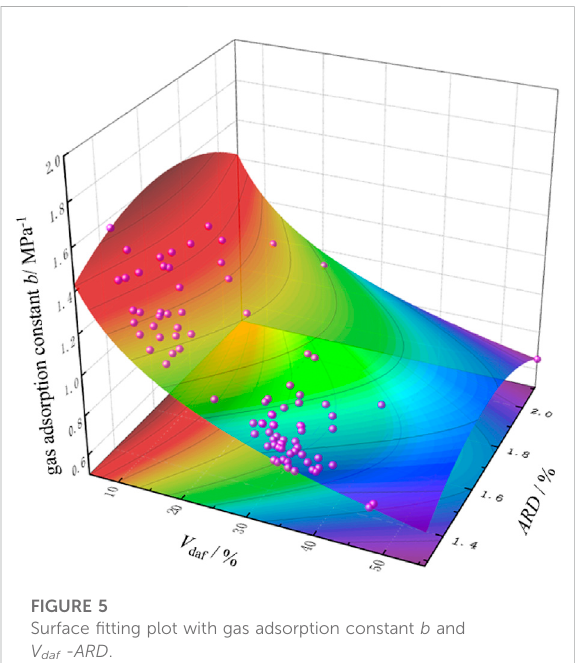
FIGURE 5 Surface fi tting plot with gas adsorption constant b and V daf - ARD .